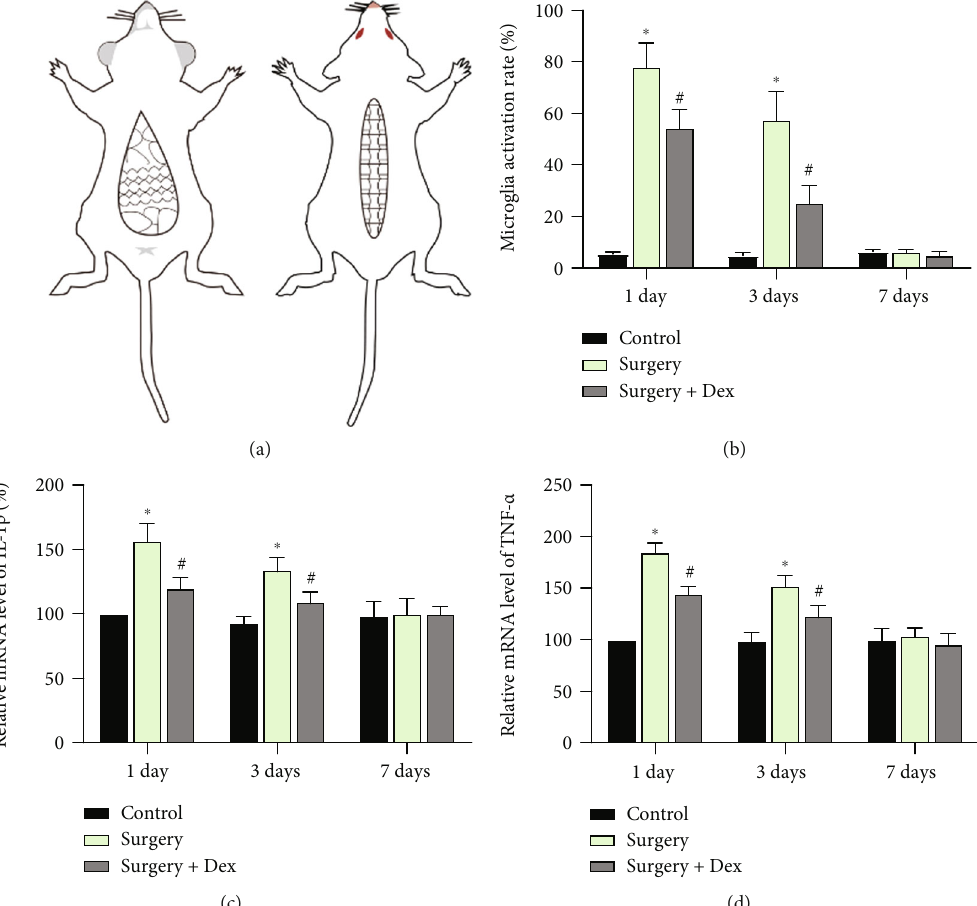
Figure 5: The establishment of a rat surgical trauma model of POCD. (a) Simpli fi ed diagram of the rat surgical trauma model. Rats were cut open longitudinally to a length of 6 cm along the dorsal median line and 5cm along the abdominal median line; the intestinal tracts were exposed for 5 min. (b) The microglial activation rate was determined from Iba1-stained microglia in the rat hippocampus for the times indicated, with or without dexmedetomidine. The mRNA expression levels of IL-1 β (c) and TNF- α (d) were determined (Sham as control, 3 animals for each group, n =3 repeated experiments). ANOVA and two tailed t -test, ∗ p < 0 : 05 , compared with control group; # p < 0 : 05 , compared with surgery